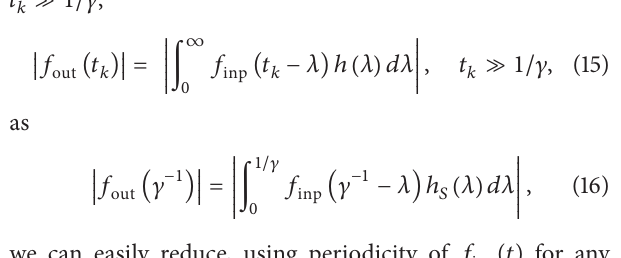
λ 1 γ (𝑡) obtained for the simplified ℎ(𝑡) Figure 12: The envelope of 𝑓 out shown in Figure